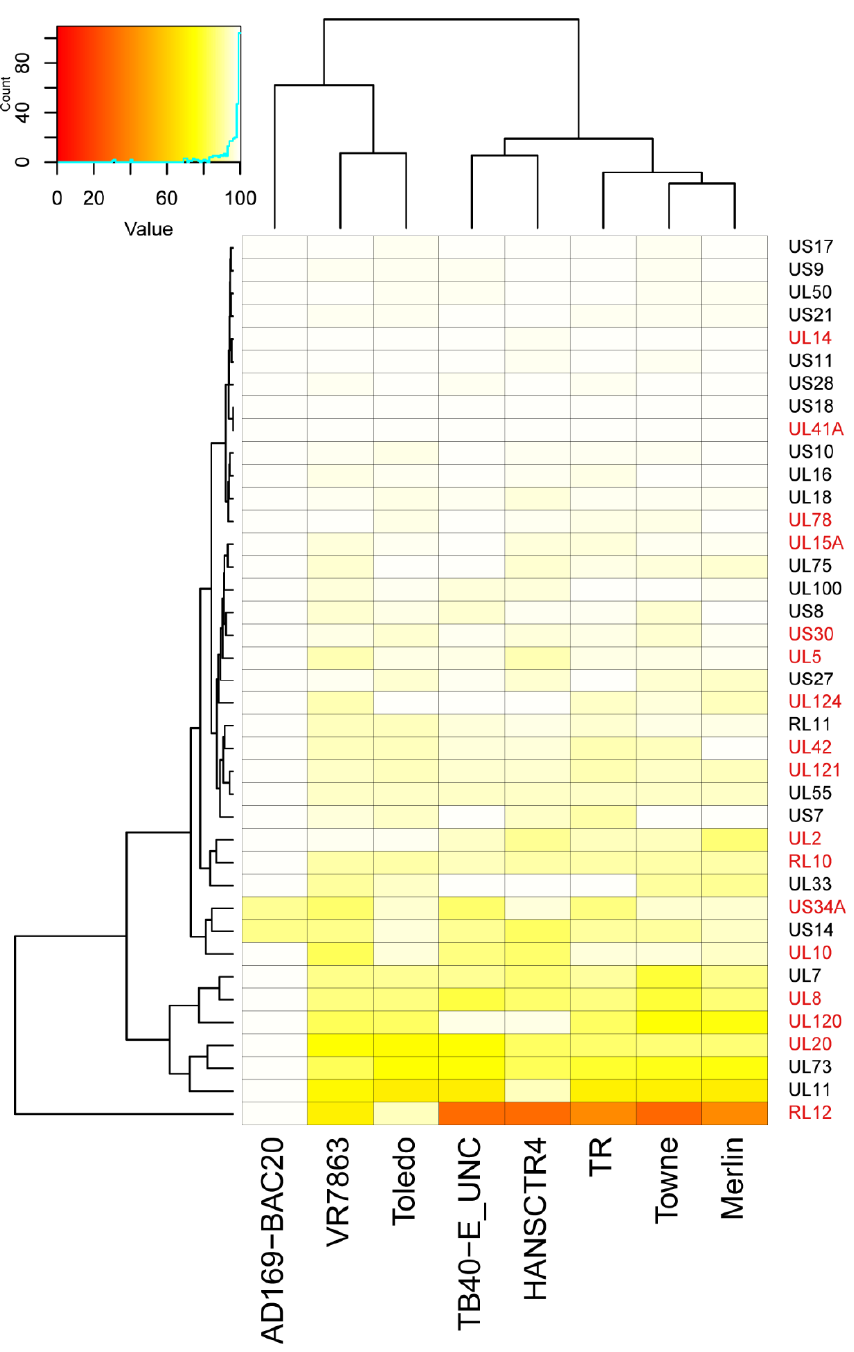
Figure 4. Percentage identity heatmap among the 39 core proteins from all the studied strains using AD169 as a reference strain. Color scales range from red (0% identity) to white (100% identity). Strains and genes were clustered following a hierarchical clustering method (HCL). Genes were clustered from top to bottom of the figure based on their similarity within the indicated strains. Core proteins with unknown functions are highlighted in red.